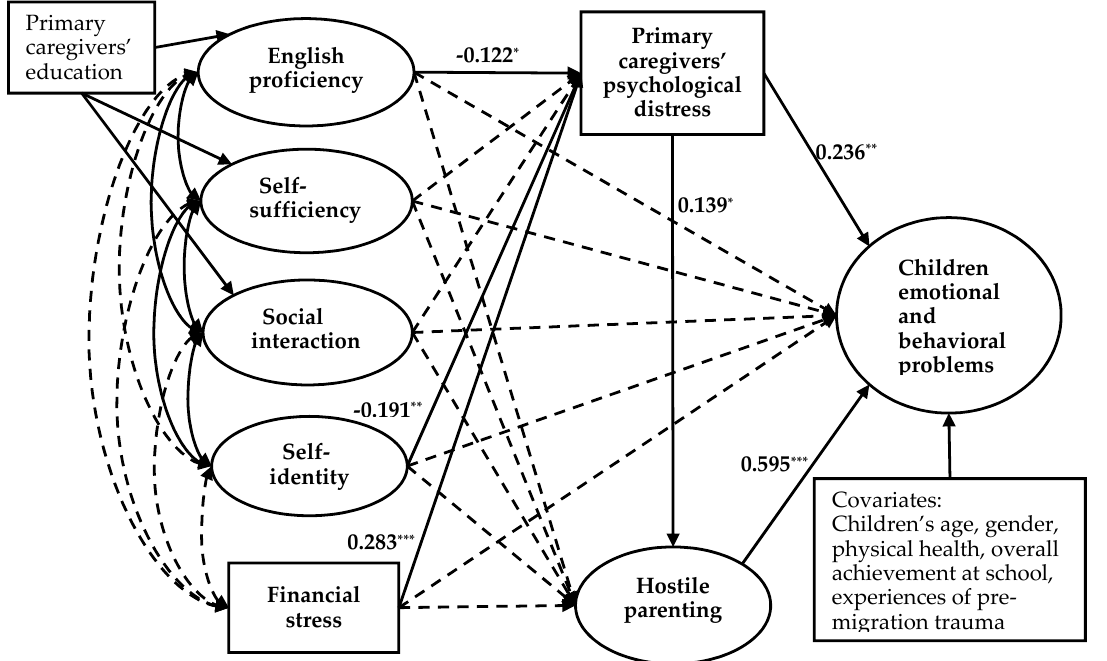
Figure 3. Extended FSM including primary caregivers’ levels of acculturation. Note. * p < 0.05, ** p < 0.01, *** p < 0.001. Coefficients are standardized path coefficients. The solid lines represent significant paths ( p < 0.05). The dashed lines represent non-significant paths. Children’s age, gender, physical health, overall achievement at school, experiences of pre-migration trauma, and primary caregivers’ education are included as covariates. Table 3. Goodness-of-fit test for the basic and extended FSM model.